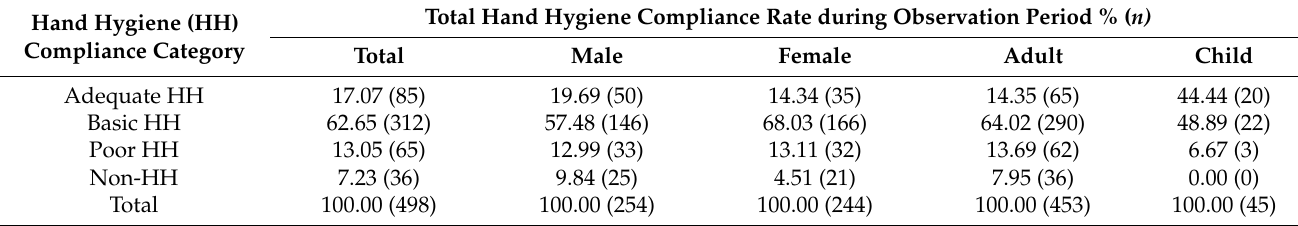
Table 1. Hand hygiene compliance rate of the general public when using public restrooms during the COVID-19 pandemic. Hand Hygiene (HH)